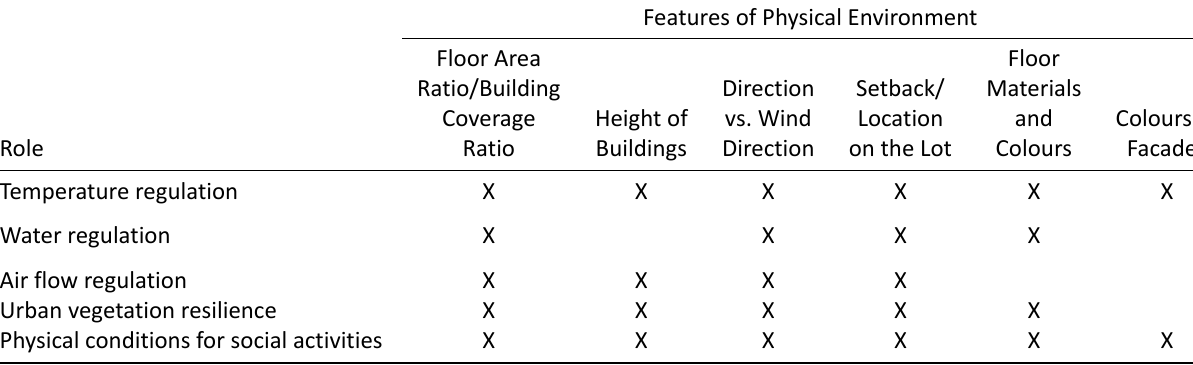
Table 3. Features of the physical environment and their role in climate